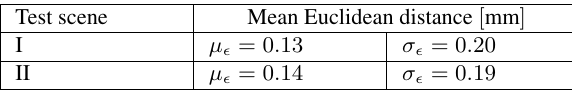
Figure 10: Test scene II as used for measurements to assess the drift of the reconstruction for larger rock panels: Two 3D prints of Valcamonica rock-art, a concrete plate and several rock samples are arranged to comprise a scene of roughly 250 cm by 50 cm.